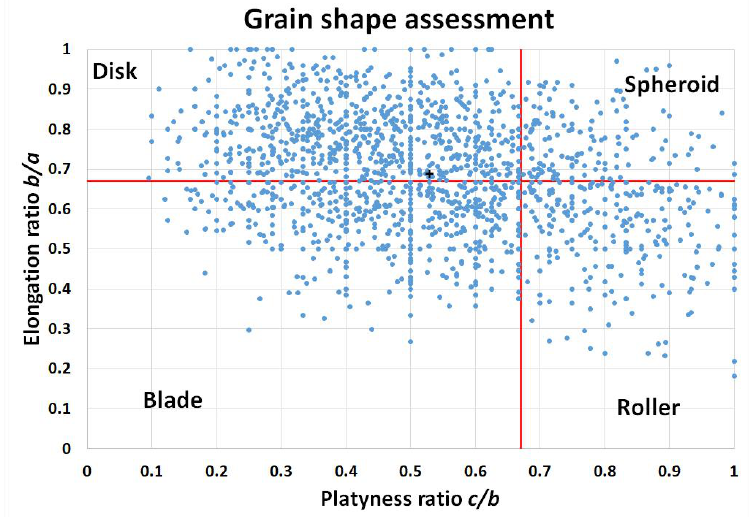
Figure 8. Grain shape assessment results (with blue dots) and the calculated average shape (marked with black +). with black +). Table 6. Manning’s n roughness values for all scenarios and all classification